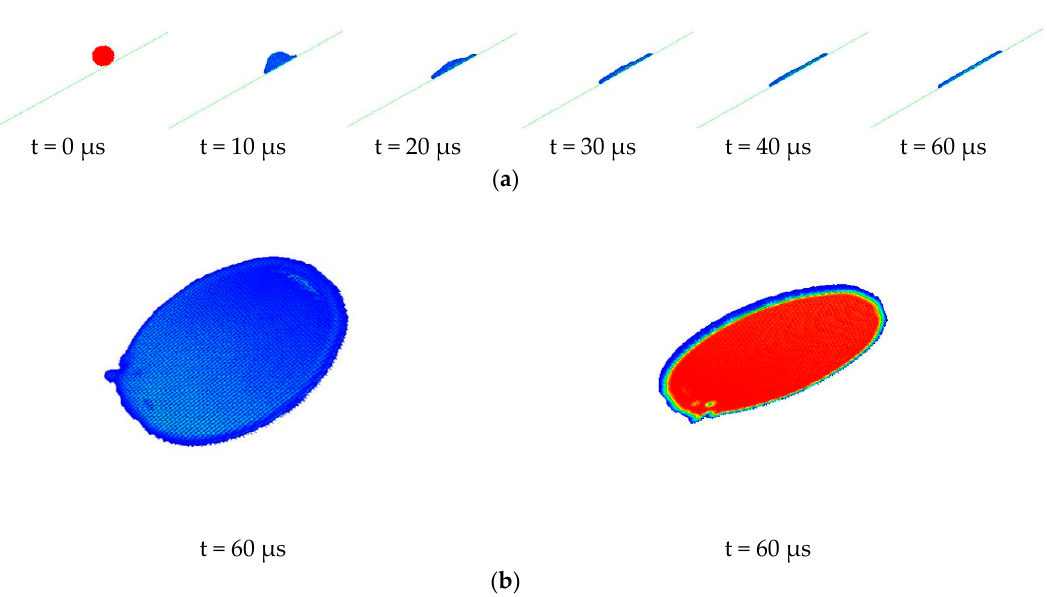
Figure 4. Spreading process of oil droplet (D = 200 µ m, v = 10 m / s, θ = 60 ◦ ), where the contour plots represent the volume fraction of oil droplet. ( a ) Spreading process of oil droplet in 60 µ s. ( b ) Spreading of oil droplet at 60 µ